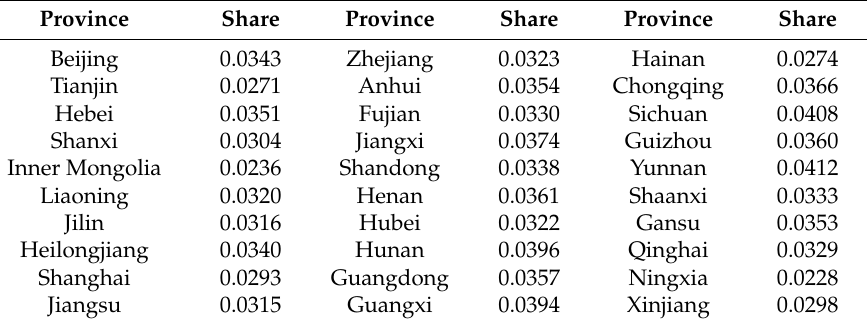
Table 3. Provincial shares for carbon emission quota.